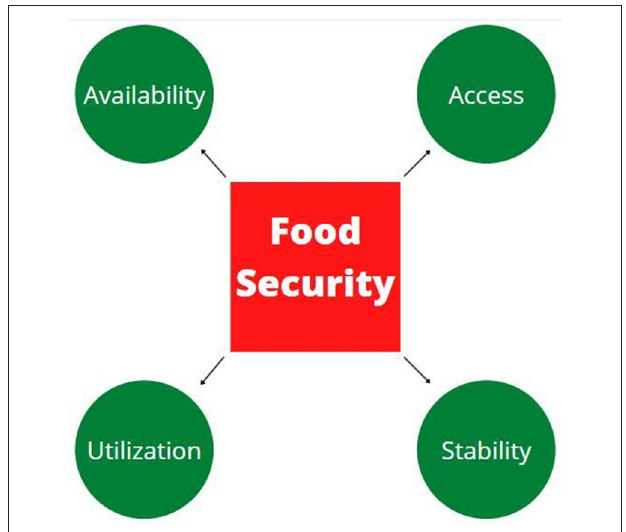
FIGURE 1 | Food security requires that food be safe, sustainably and equitably accessible, and utilized by all people to meet their dietary needs and food preferences. In regards to cellular agriculture, these requirements can be broken into the elements used in section Supply System Models: